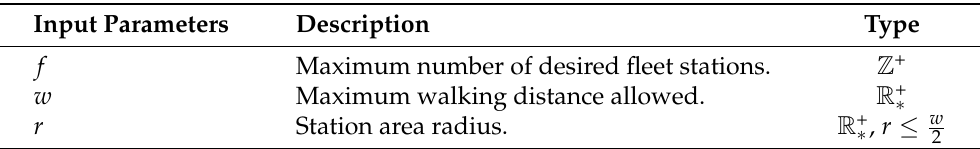
Table 1. FPP input